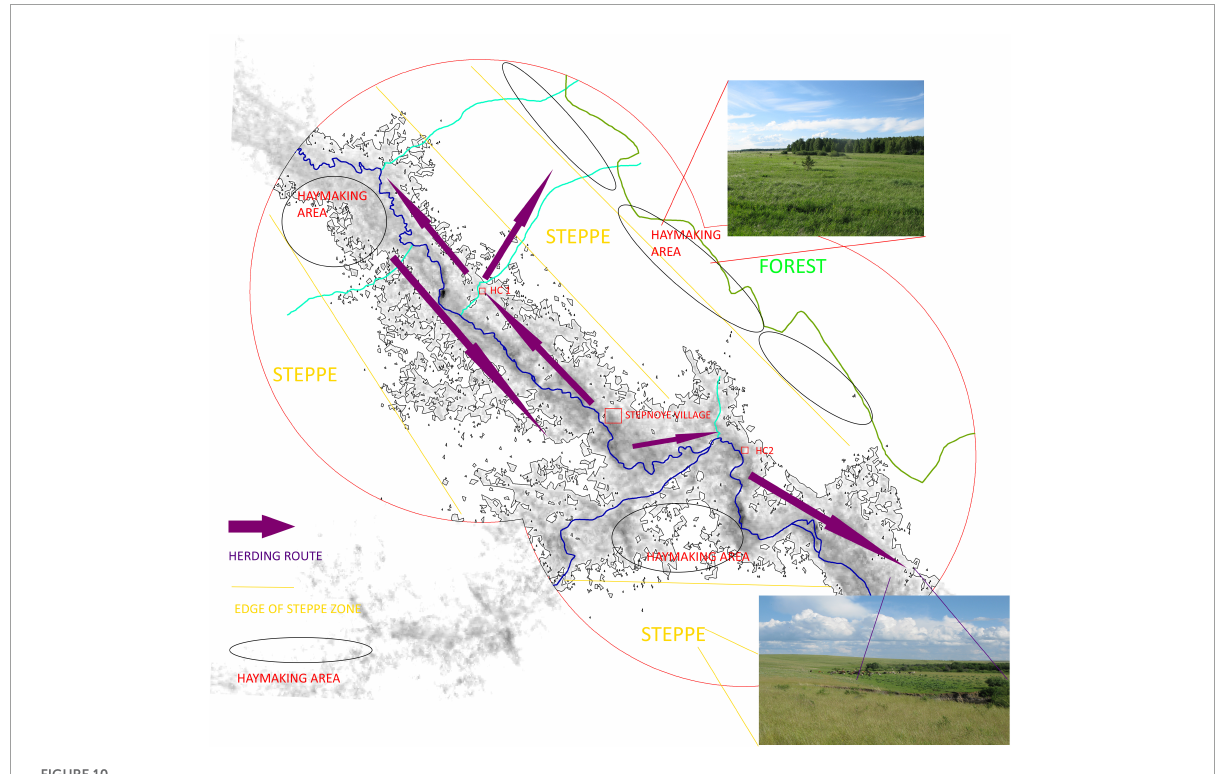
FIGURE10 Map showing the general herding pattern during 2017 survey period.